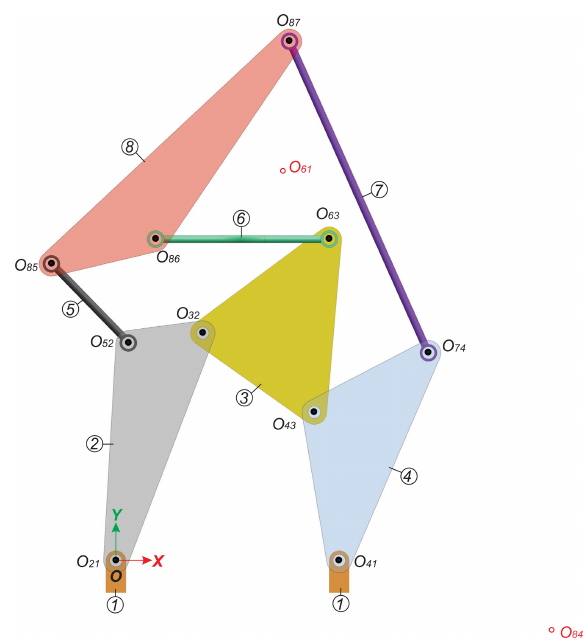
Figure 3. Single flyer planar